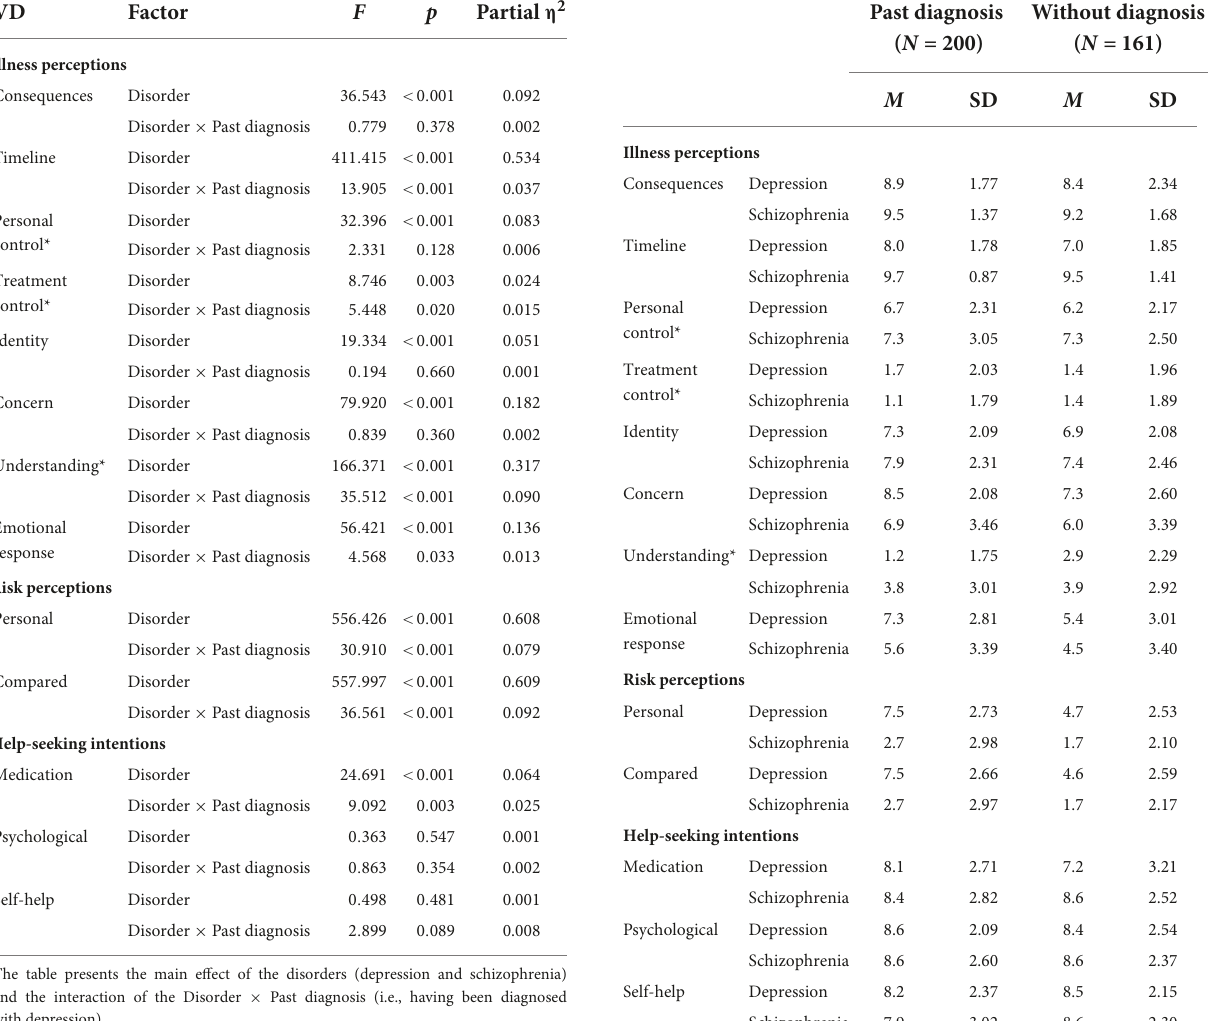
TABLE 2 Means and SD for depression or schizophrenia considering past diagnosis ( n =